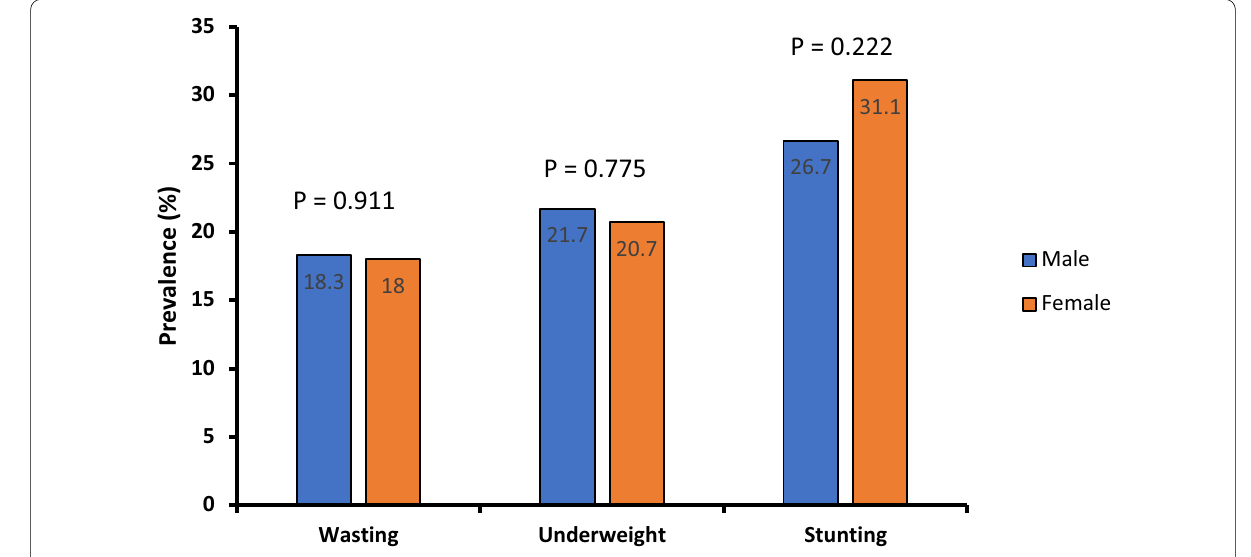
Fig. 3 Prevalence of wasting, underweight and stunting with respect to sex